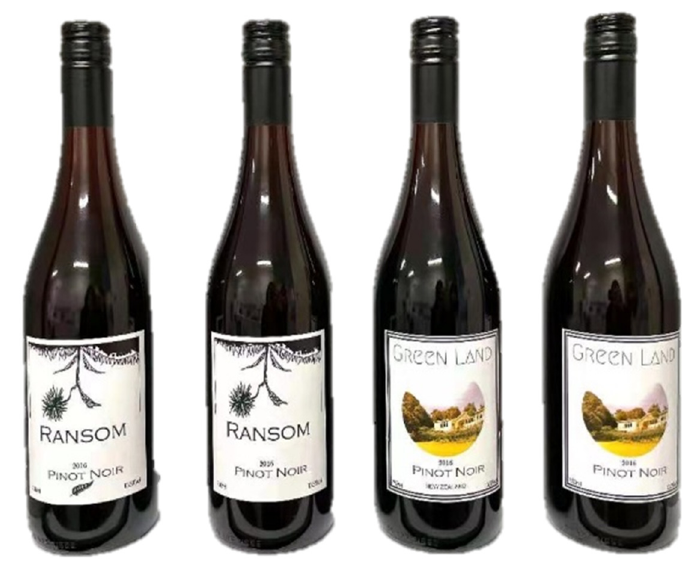
Figure 2. Wine bottles with manipulated labels showed in study